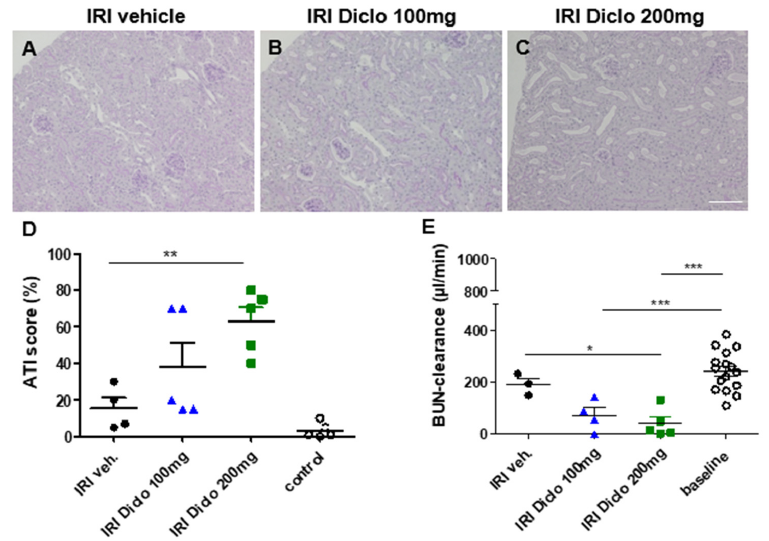
Figure 1. Renal morphology and function 24 h after renal ischemia reperfusion injury (IRI) and diclofenac treatment. PAS-stained kidney sections of IRI mice treated with vehicle ( A ), or a single oral dose of 100 mg diclofenac ( B ) or 200 mg diclofenac ( C ) are shown. Acute tubular injury (ATI) score is shown in (D). Diclofenac caused aggravation of renal damage in a dose-dependent manner. Renal morphology of contralateral control kidneys was comparable between groups and the untouched contralateral kidney of the IRI vehicle group is shown here as control. For evaluation of renal function, bilateral renal IRI was performed and urine of IRI mice treated with vehicle or a single dose of 100 mg or 200 mg diclofenac was collected in metabolic cages 24 h after IRI. Blood urea nitrogen (BUN) clearance was calculated and is shown in (E). A single oral dose of 200 mg diclofenac after IRI markedly worsened renal function. In the IRI groups, n = 3–5 mice are shown. Baseline BUN clearance was measured in n = 16 mice. * p < 0.05, ** p < 0.01, *** p < 0.001. Scale bar 100 μ m.